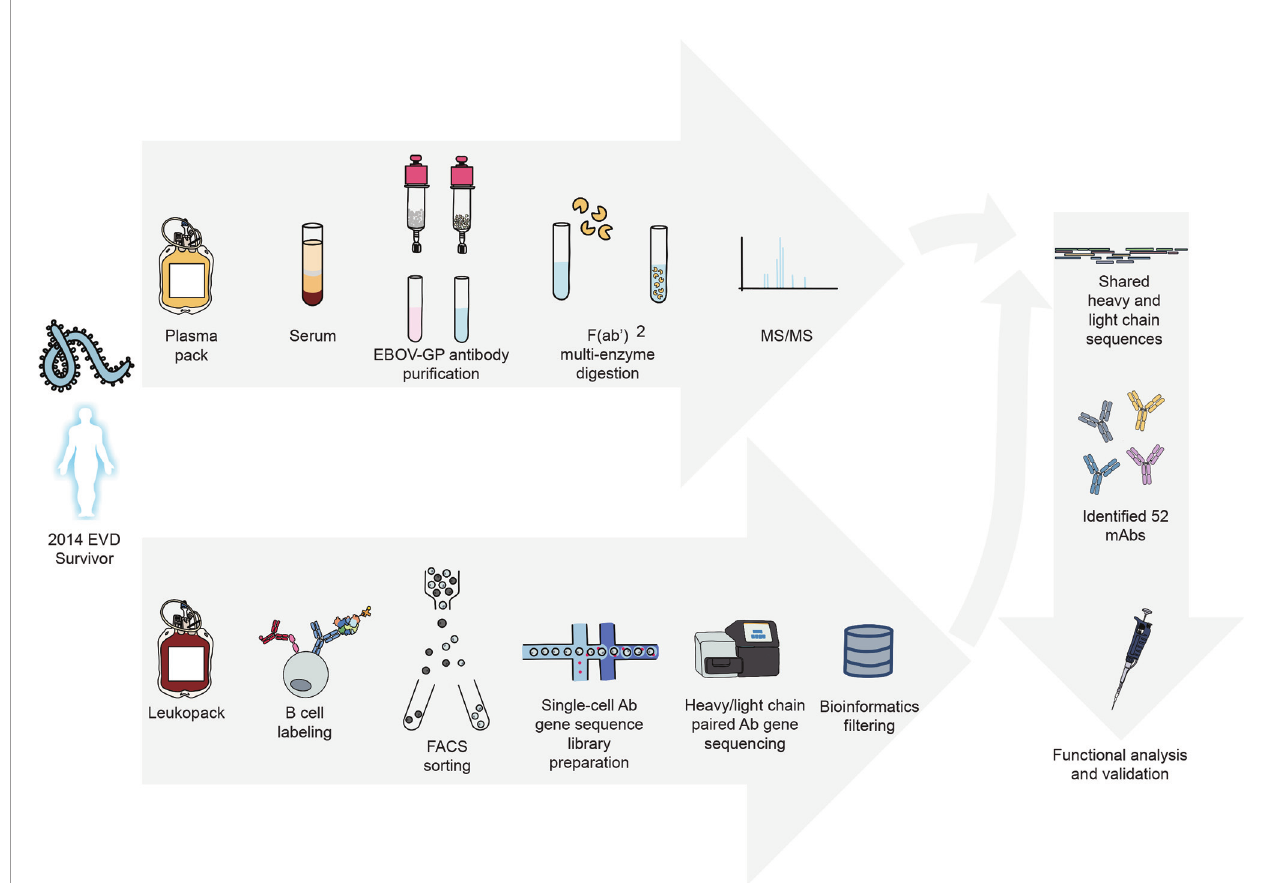
FIGURE 1 | Proteo-genomics work fl ow for the discovery of ebolavirus GP-speci fi c monoclonal antibodies in convalescent human plasma. A cartoon representation is shown of key work fl ow steps, which included collection of convalescent plasma from EVD survivor, af fi nity puri fi cation of polyclonal GP-speci fi c antibodies from plasma, mass-spectrometric analysis of plasma antibody protein sequences, isolation of GP-speci fi c B cells from the peripheral blood mononuclear cells of an EVD survivor, single-cell V(D)J gene sequence analysis, bioinformatics analysis to identify shared proteo-genomic antibody heavy and light chain variable region sequences, recombinant expression of identi fi ed monoclonal antibodies, and functional analysis of recombinant